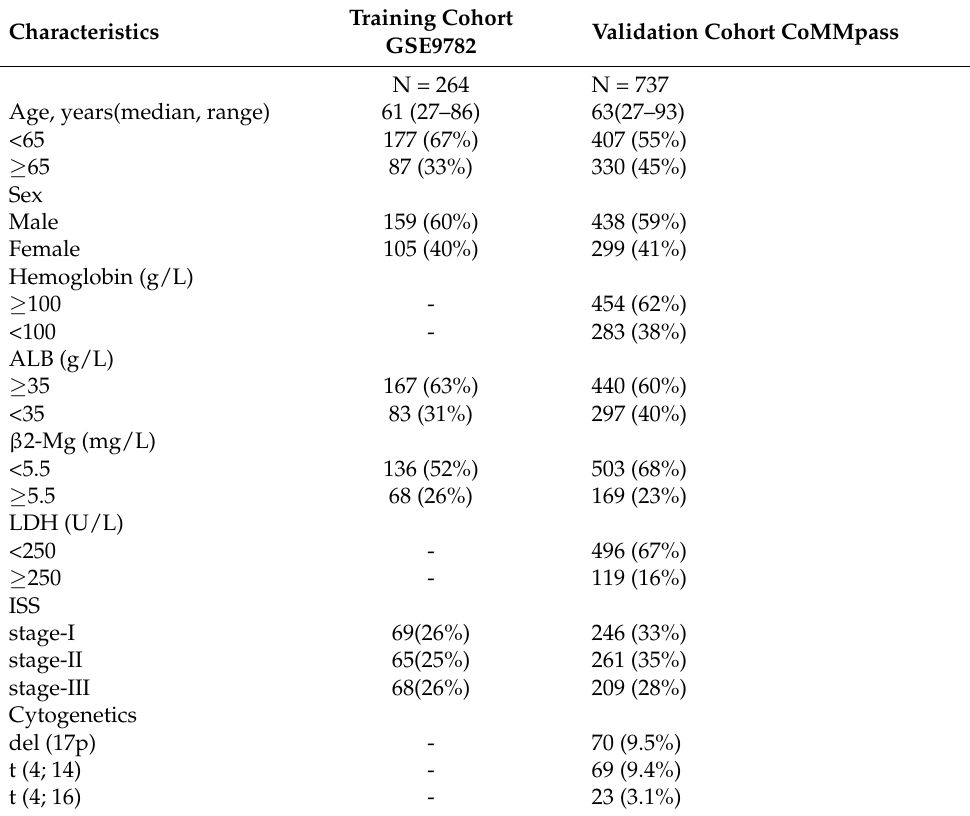
Table 1. Baseline clinical features of patients in the training and validation